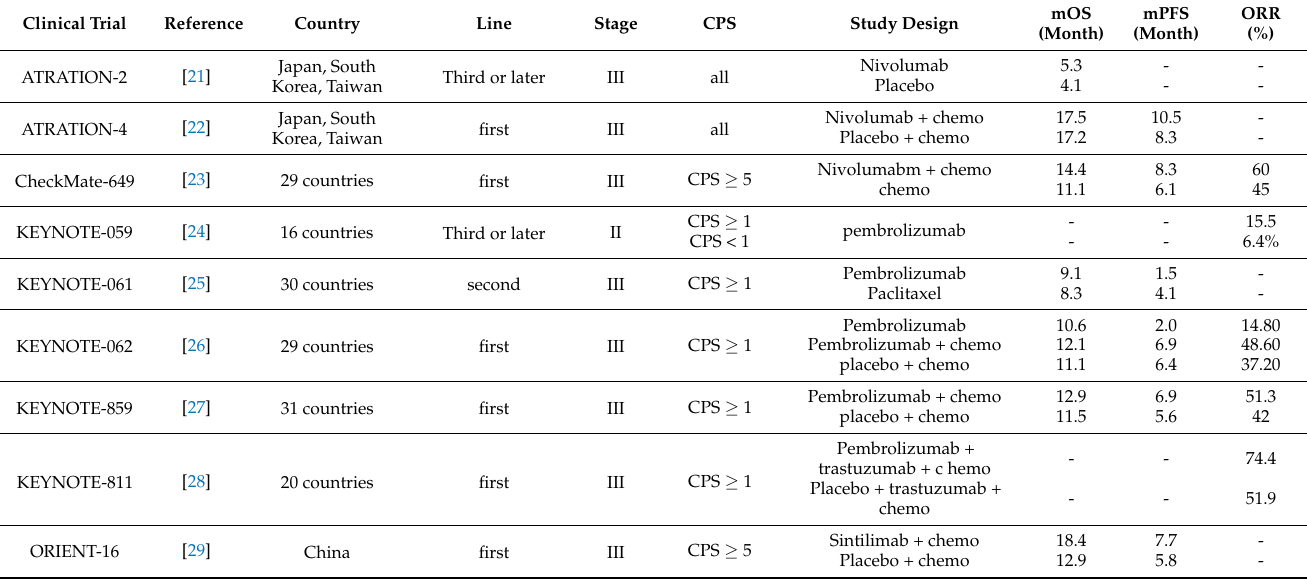
Table 1. Clinical trials of anti-PD-1 antibody for